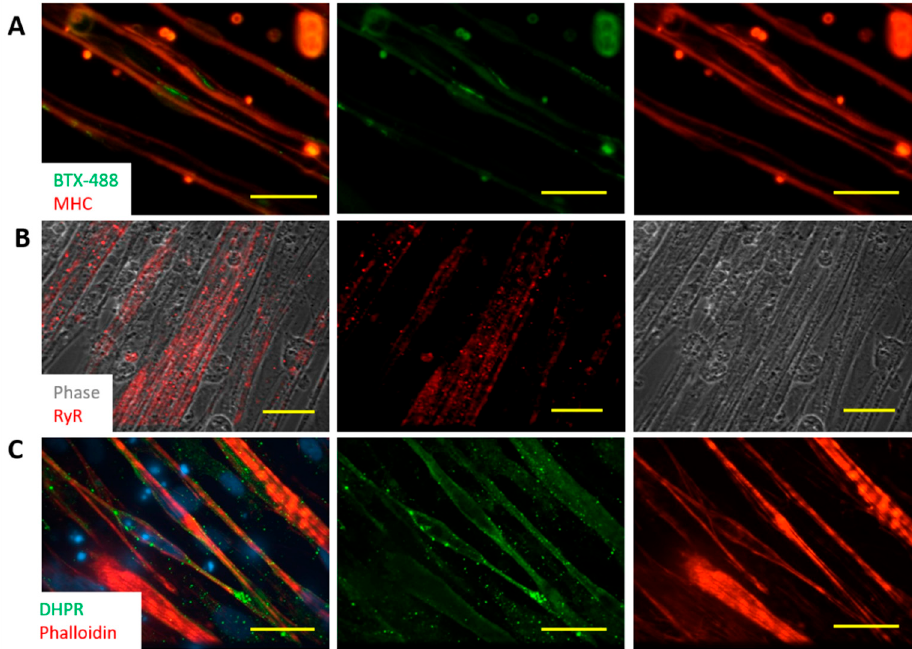
Figure 4. Characterization of myofibers differentiated from human iPSCs. ( A ) Expression of AchRs in a Day 15 SKM culture was demonstrated by staining with BTX-448. Myotubes were visualized with Myosin Heavy Chain (MHC) immunostaining. Scale bar: 100 µm. ( B , C ) Immunostaining of these myotubes for Ryanodine Receptor (RyR) ( B ) and Dihydropyridine Receptors (DHPR) ( C ) to examine the formation of excitation-contraction coupling in a Day 15 culture. Scale bars are 25 µm and 50 µm in ( B) and ( C) , respectively.